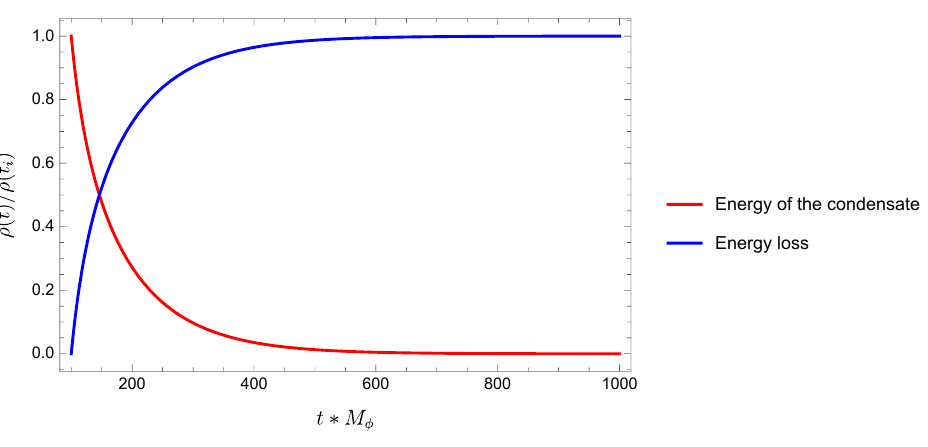
Figure 18 . Energy transfer from the condensate to the produced particles in a matter-dominated universe. The evolution of the condensate comoving energy density and of the energy loss from the condensate are shown in the red and blue lines, respectively. The energy transfer from the condensate to the produced particles in a matter-dominated universe is efficient in presence of a non-vanishing self-energy